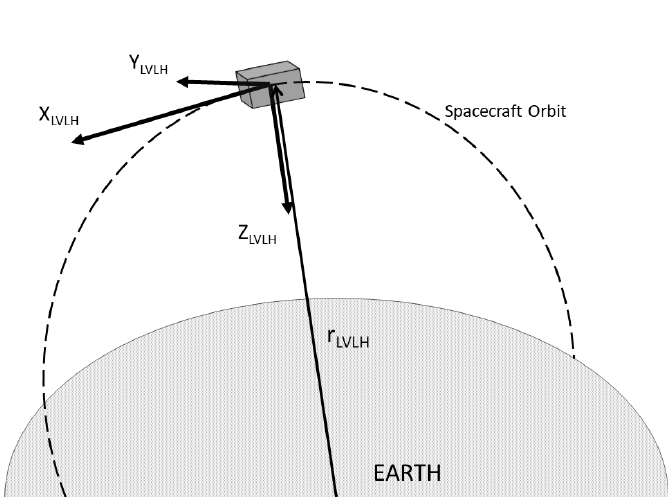
Figure 2. LVLH (Local-Vertical-Local-Horizontal) frame